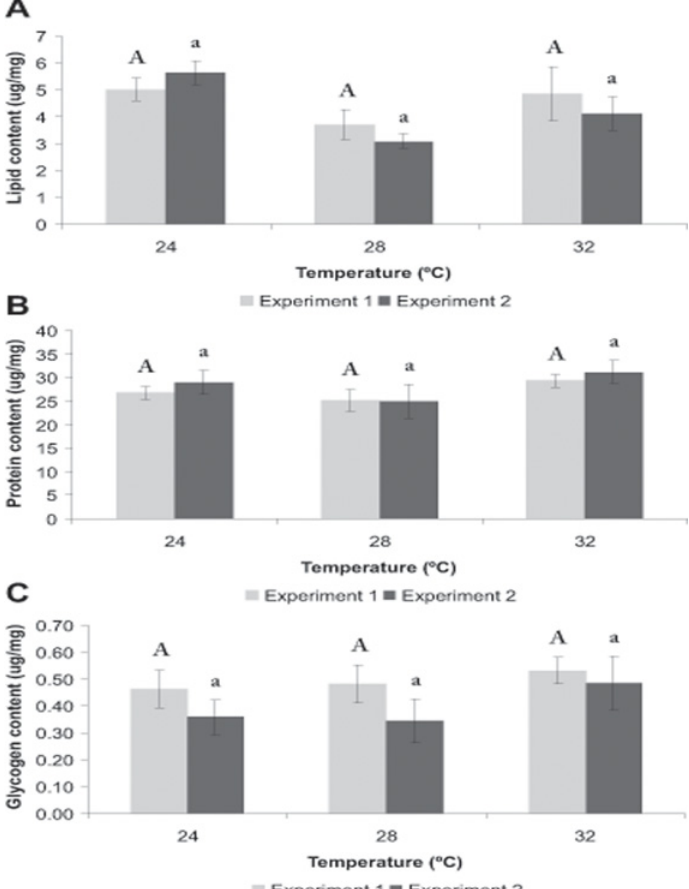
Fig 5. Biochemical composition of shrimps during the Growth period of Experiment 1 and Experiment 2. Neocaridina heteropoda heteropoda juveniles were reared at three different water temperatures (24, 28 or 32°C) over a 90-day period and the lipid (A), protein (B), and glycogen (C) concentrations (mean ± SE) were measured at the end of that period. Different letters indicate statistically significant differences among treatments for each experiment ( P < 0.05). In both experiments, the protein and glycogen concentrations were similar among treatments, while the lipid concentration tended to be lowest in shrimps maintained at 28° C and highest in shrimps maintained at